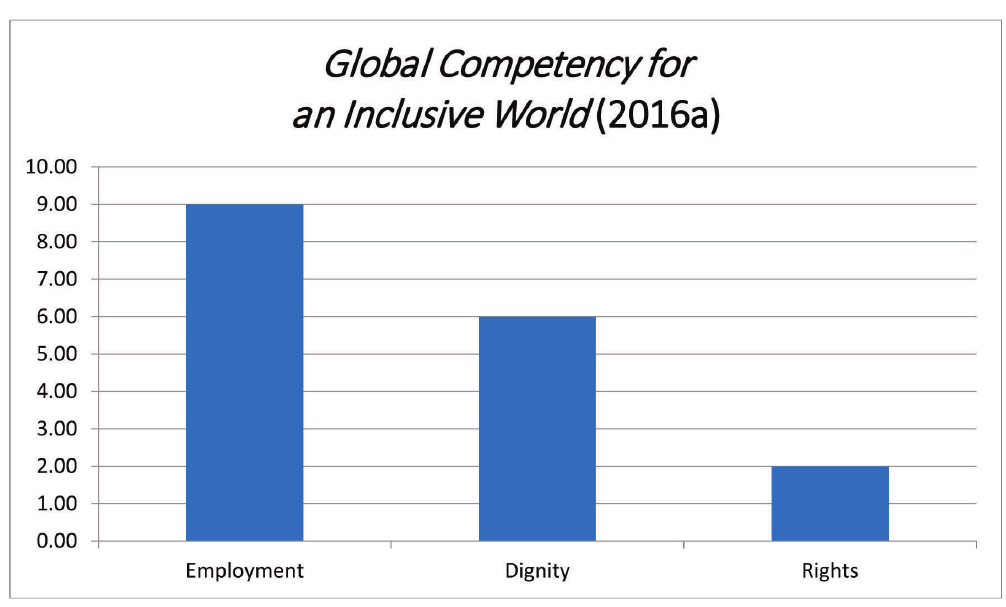
Figure 2: OECD (2016a) Cluster 2 codes